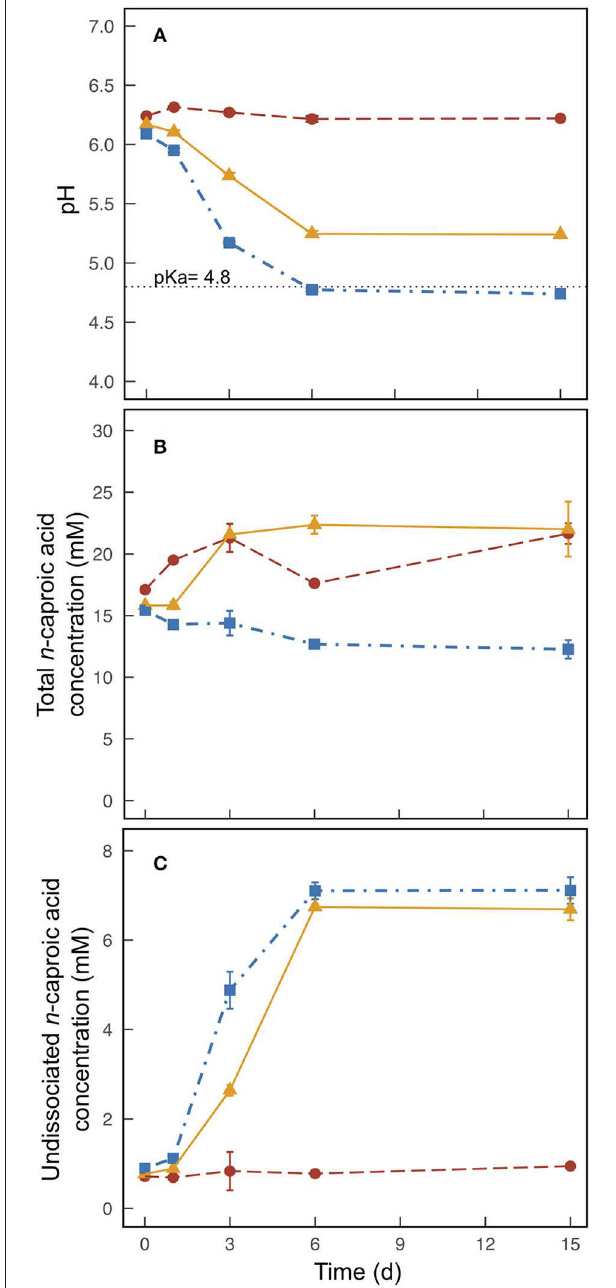
FIGURE 2 | Average pH (A) , total n -caproic acid concentration (undissociated plus dissociated) (B) , and undissociated n -caproic acid concentration (C) found in duplicate batch fermentation media bottles for Experiment 2 with banana mash added at 0 % (m/m) ( • ), 10 % (m/m) ( N ), and 20 % (m/m) ( (cid:4) ). Error bars indicate the range of the measured values between the duplicate media bottles. The dotted horizontal line at pH = 4.8 indicates the pKa of carboxylic